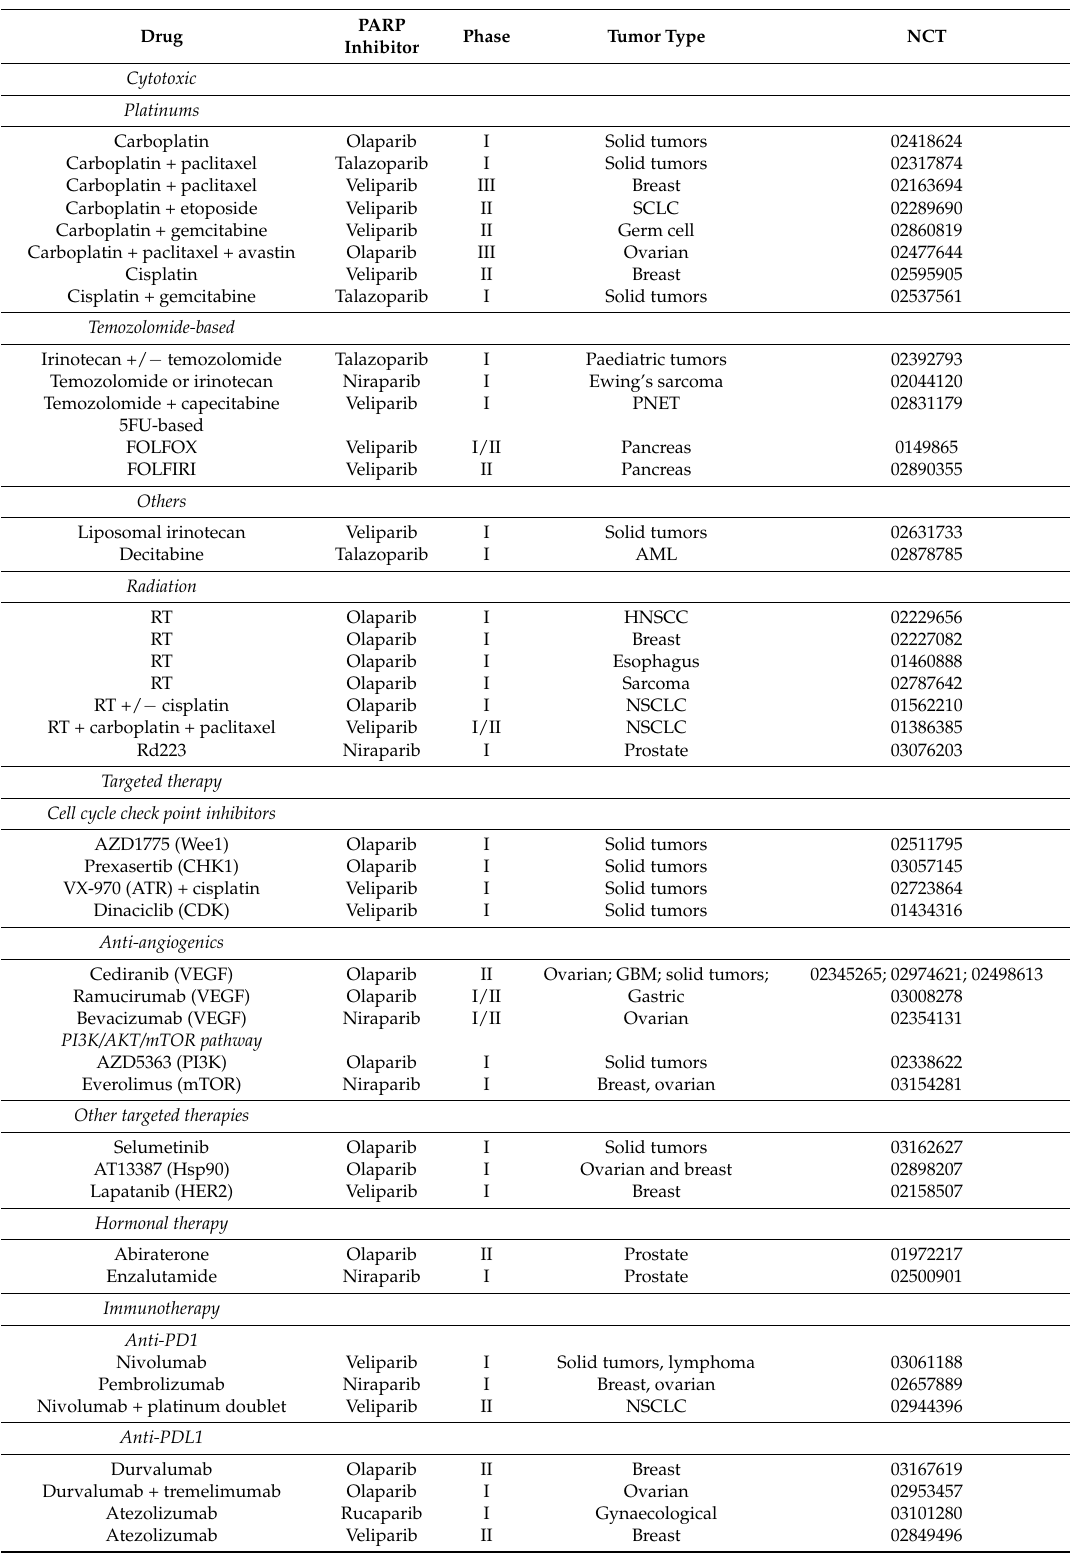
Table 2. Selected ongoing trials of combination strategies with PARP